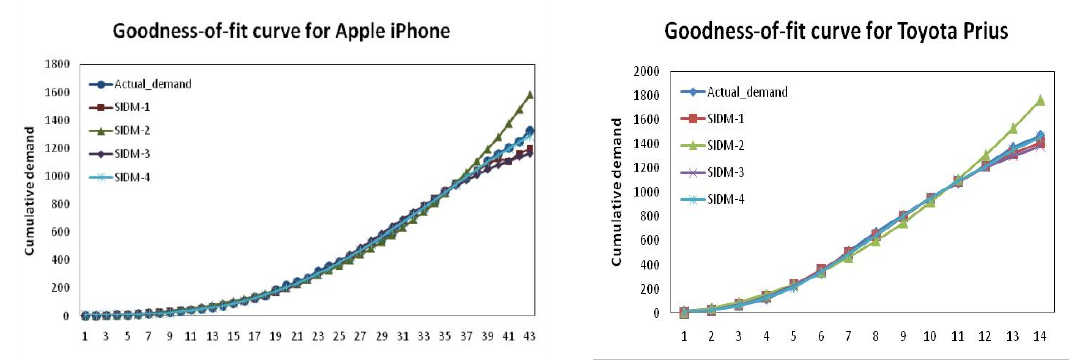
Figure 1. Goodness-of-fit curves for Apple iPhone (DS1) and Toyota Prius (DS2)